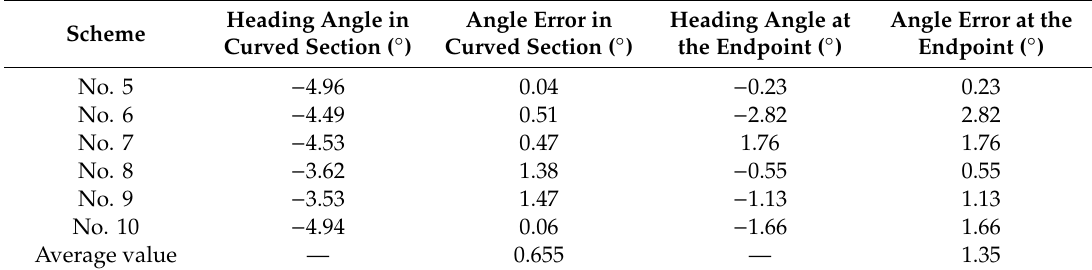
Table 4. Data statistics for the heading